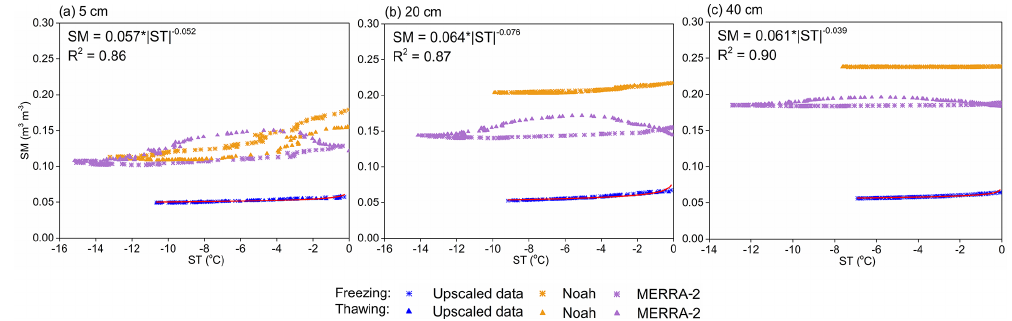
Figure 10. Same as Fig. 7 but for the Shiquanhe